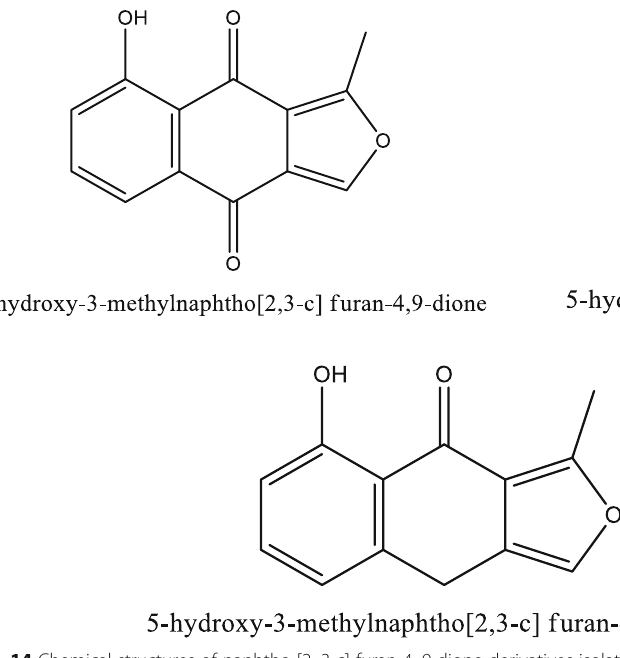
Fig. 14 Chemical structures of naphtho [2, 3-c] furan-4, 9-dione derivatives isolated from A.